Question: What style of plot is this figure drawn as?
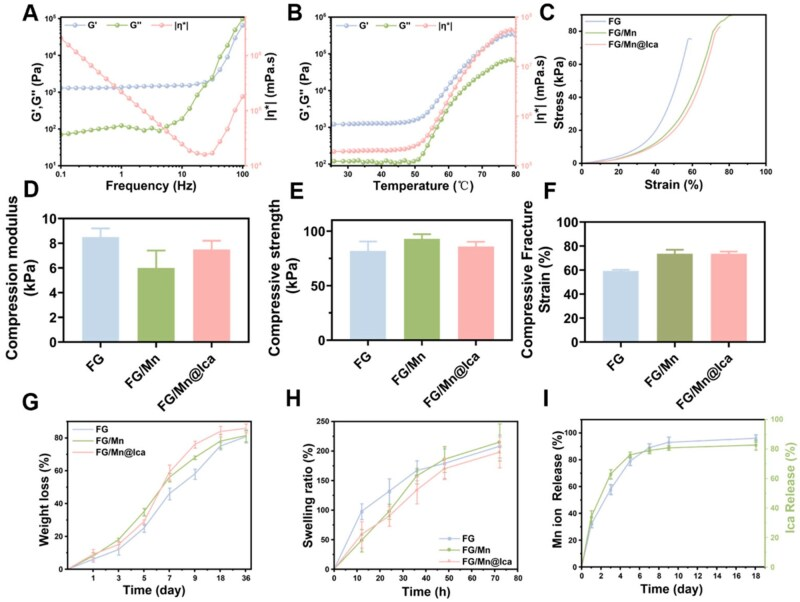
Answer: line